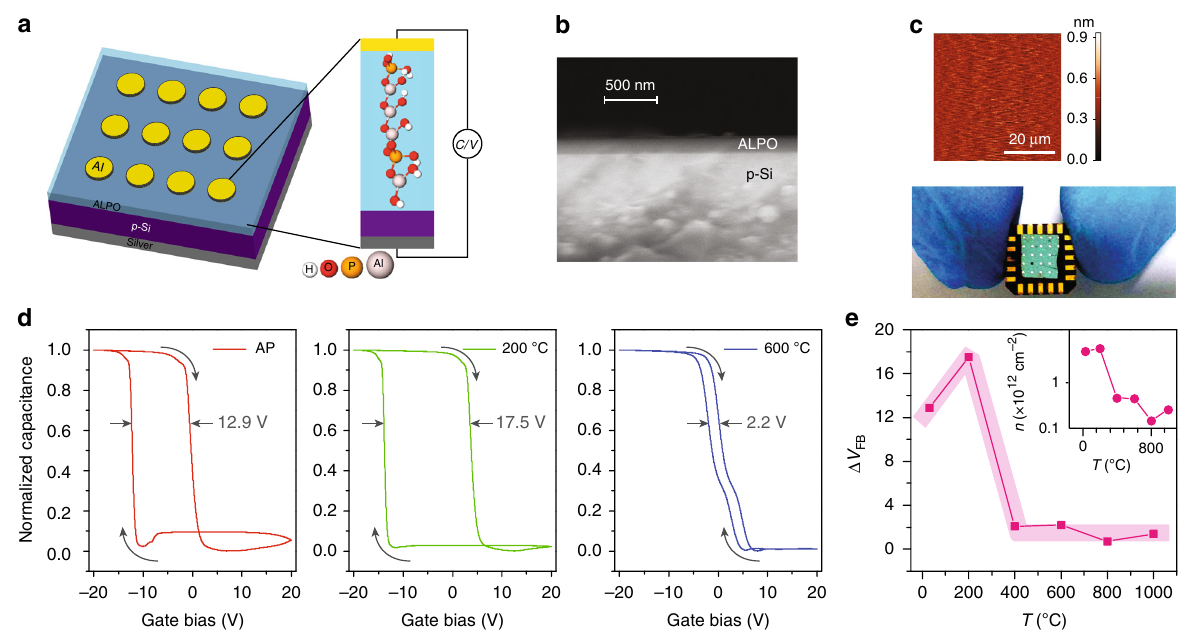
Fig. 1 Device and deep level charge trapping response. a Schematic of device architecture. b Cross-sectional scanning electron microscopy (SEM) image of a typical device (thickness of 139 nm). c (top-panel) Atomic force topography of the surface of the devices. (bottom-panel) Optical image taken with camera of an array of devices. d C – V traces of as prepared (AP), heated at 200 and 600 °C respectively (Supplementary Note 2). The heating was done for 1 h for each sample. C – V was measured with the up-down DC sweep of ±20 V at a rate of 2 V min − 1 on the gate (Gate Bias) of the metal-insulator- semiconductor (MIS) while imposing a small AC with amplitude and frequency of 100 mV and 100 kHz, respectively. e Variation of hysteresis window ( Δ V FB ) as a function of heating temperature. (inset) variation of trap density as a function of heating temperature